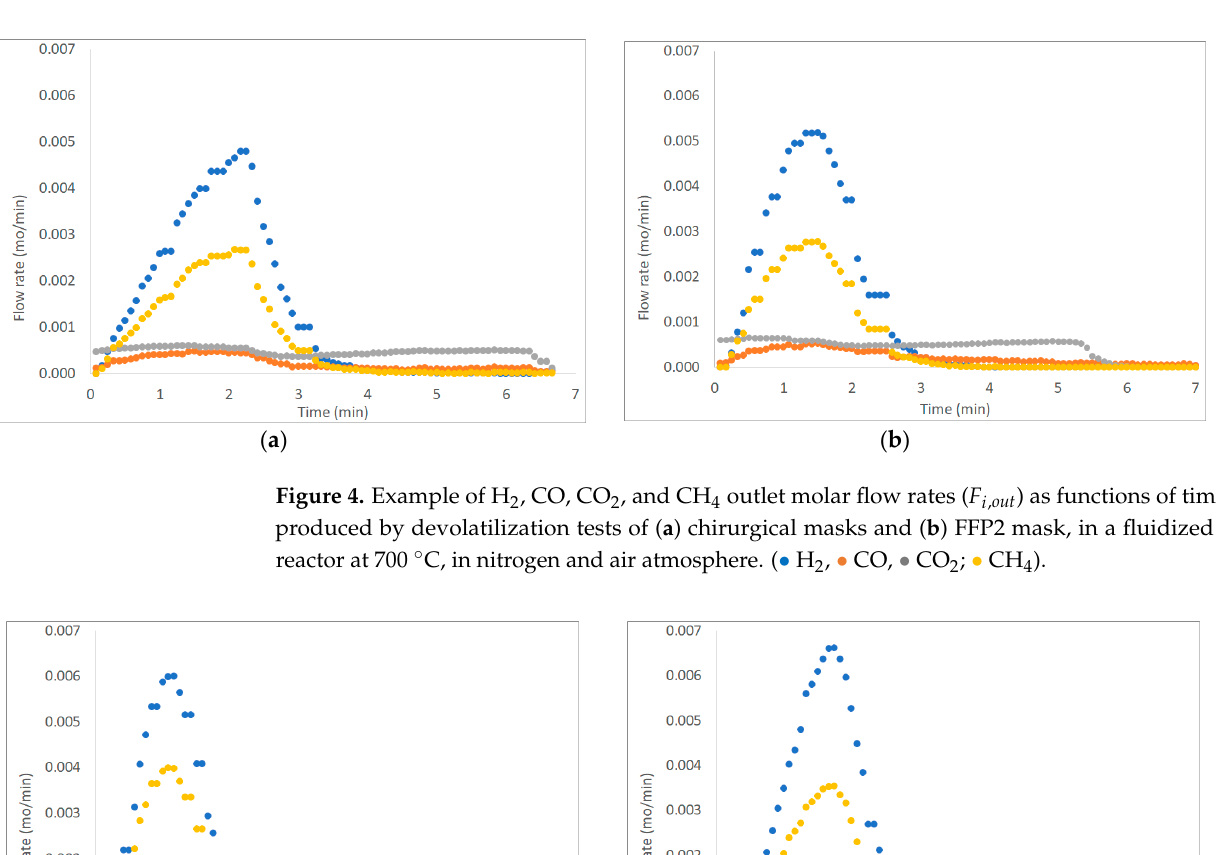
Figure 3. Example of H 2 , CO, CO 2 , and CH 4 outlet molar flow rates ( F i , out ) as functions of time ( t ), produced by devolatilization tests of ( a ) chirurgical masks and ( b ) FFP2 mask, in a fluidized bed